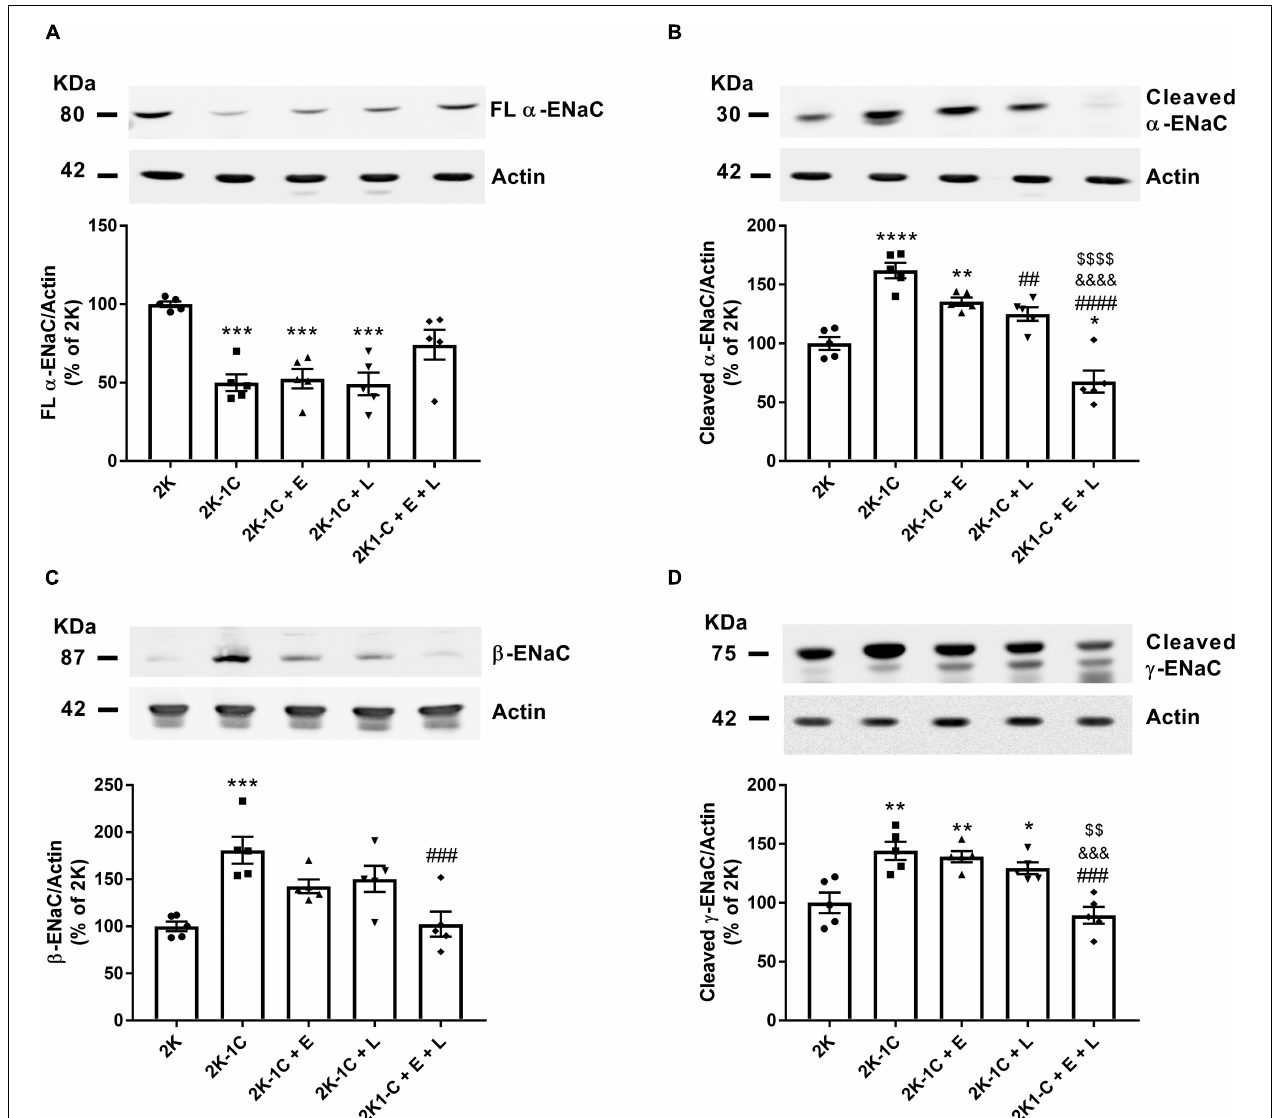
FIGURE 7 | Effect of dual versus single RAS blockade on the expression of total and cleaved ENaC subunits in the non-clipped kidney of renovascular hypertensive rats. Samples isolated from the non-clipped kidney of renovascular-hypertensive rats treated with enalapril (2K-1C + E, 20 mg/kg/day), losartan (2K-1C + L, 30 mg/kg/day), enalapril plus losartan (2K-1C + E + L, 30 and 20 mg/kg/day, respectively), or vehicle (2K-1C) and vehicle-treated control rats (2K) containing equal amounts of membrane proteins (75 µ g for α -ENaC, β -ENaC, and γ -ENaC and 20 µ g for actin) were subjected to SDS-PAGE, after which the proteins were transferred to a PVDF membrane and incubated with primary antibodies. Actin was used as a loading control. Representative immunoblots of electrophoresed renal membrane proteins and graphical representation of the relative expression of (A) Full-length (FL) α -ENaC, (B) cleaved α -ENaC, (C) β -ENaC, (D) cleaved γ -ENaC. The values represent individual measurements and the means ± SEM. * P < 0.05, ** P < 0.01, *** P < 0.001 and **** P < 0.0001 vs. 2K; ## P < 0.01, ### P < 0.001, and #### P < 0.0001 vs. 2K-1C; &&& P < 0.001 and &&&& P < 0.0001 vs. 2K-1C + E; $$ P < 0.01 and $$$$ P < 0.0001 vs. 2K-1C +